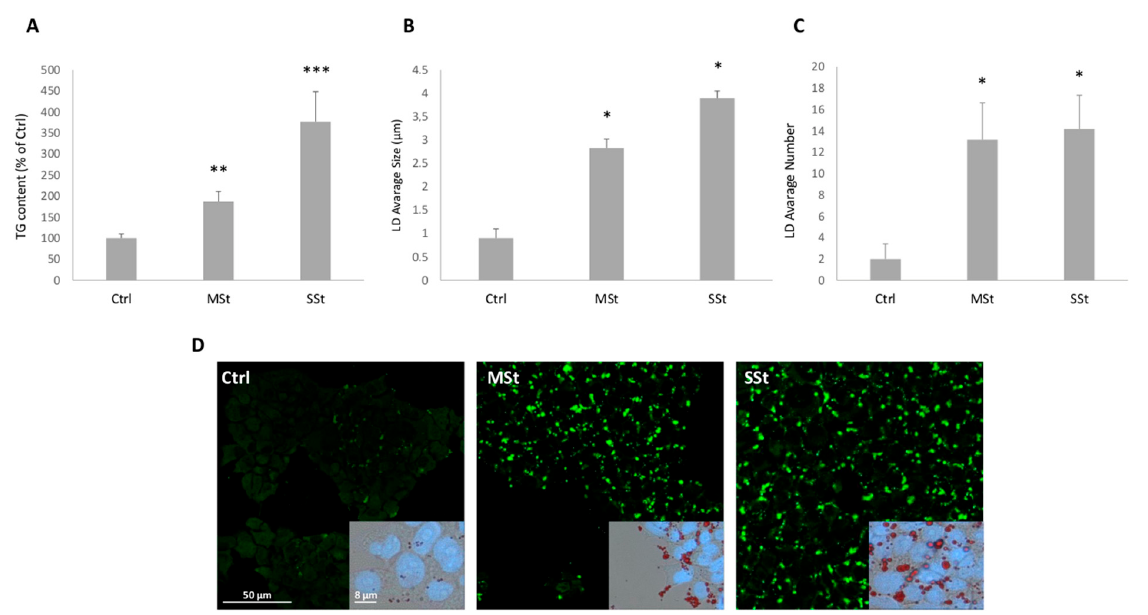
Figure 2. Lipid accumulation in moderate and severe steatosis models. For FaO cells incubated in the absence (Ctrl) or in the presence of moderate in vitro steatosis (MSt), and severe steatosis (SSt) we show: ( A ) TG content expressed as percent TG content relative to controls, normalized for proteins determined with Bradford assay. ( B , C ) Average size of LDs. and number of LDs/cell. Values are mean ± S.D. from at least three independent experiments. Statistical significance between groups was assessed by ANOVA followed by Tukey’s test. Symbols: Ctrl vs. all treatments * p ≤ 0.05. ( D ) Microphotographs of cells stained with BODIPI 493/503 (magnification 20 × ; Bar: 50 µ m) and microphotographs of cells stained simultaneously with ORO and DAPI (magnification 40 × ; Bar: 8 µ m) were captured. For microscopy analyses a Leica DMRB light microscope equipped with a Leica CCD camera DFC420C was employed. Symbols: Ctrl vs. all treatments * p ≤ 0.05, ** p ≤ 0.01, *** p ≤ 0.001.